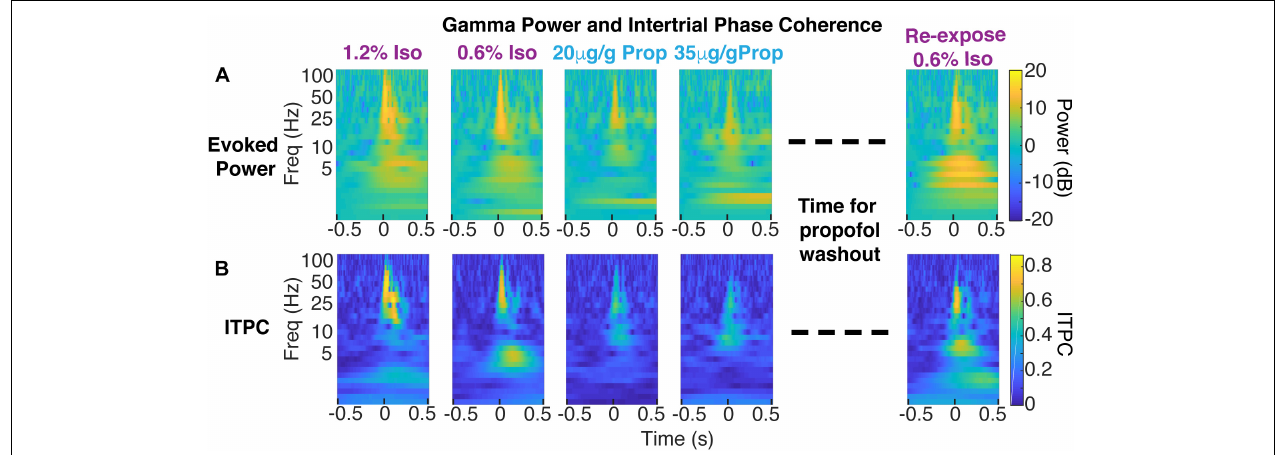
FIGURE 6 | Decrease in coherent evoked gamma power in propofol compared to isoflurane within the same animal. (A) Color plot of average evoked power (first isoflurane exposure in the left panels, propofol exposures in the middle panels, and re-exposure to isoflurane acquired 1 h after propofol wash out in the right panels). (B) Color plot of